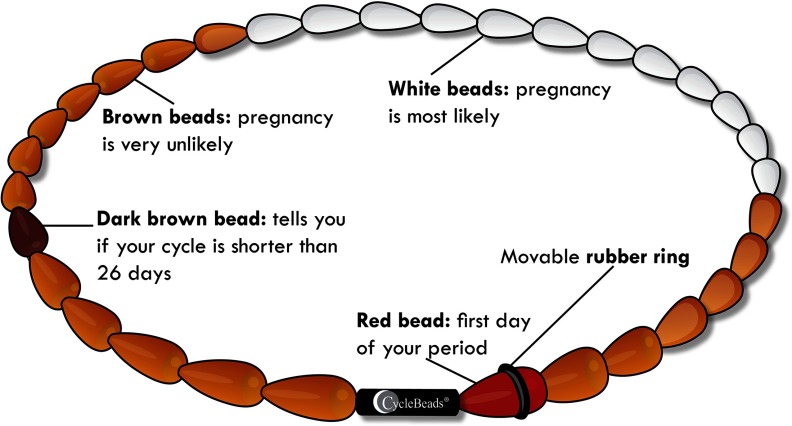
CycleBeads have colored beads that each correspond to 1 menstrual cycle day. © 2019/Institute for Reproductive Health